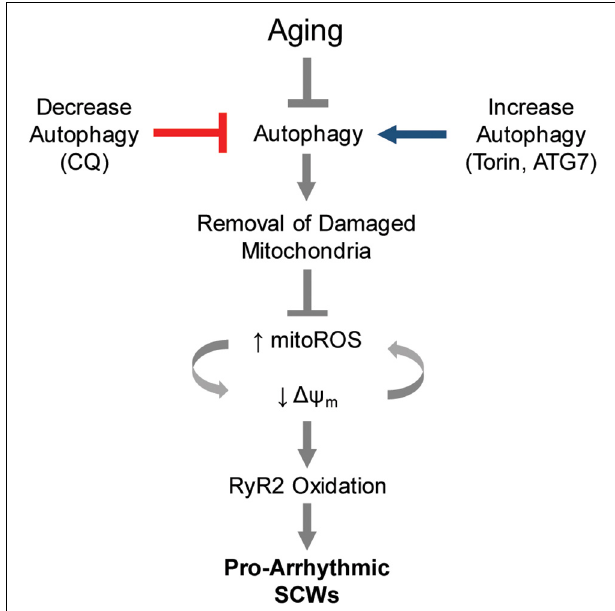
FIGURE 6 | Proposed model of autophagy control of Ca 2 + -mediated cardiac arrhythmia. Autophagy is a major cause of increased mito-ROS production in the aging heart. Blocking or enhancing autophagy is sufficient to modify pathologic mito-ROS production and (cid:49) ψ m during normal aging, thereby controlling the instance of pro-arrhythmic spontaneous Ca 2 + release via oxidized